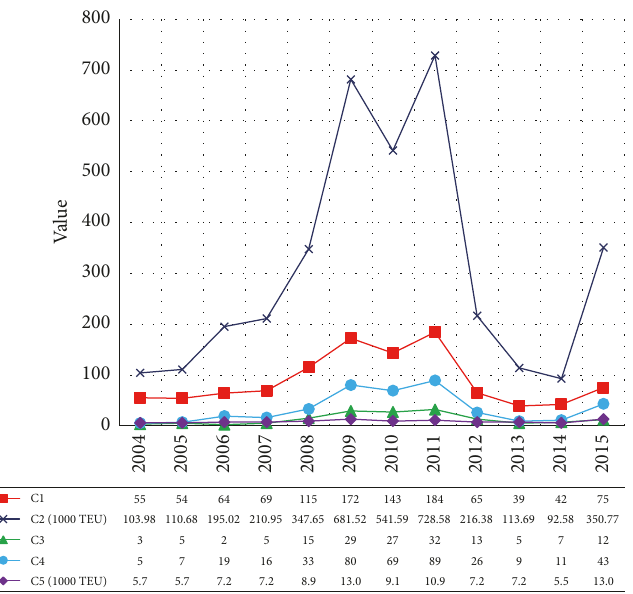
Figure 13: Past trends of LSCI’s components based on PMO data.